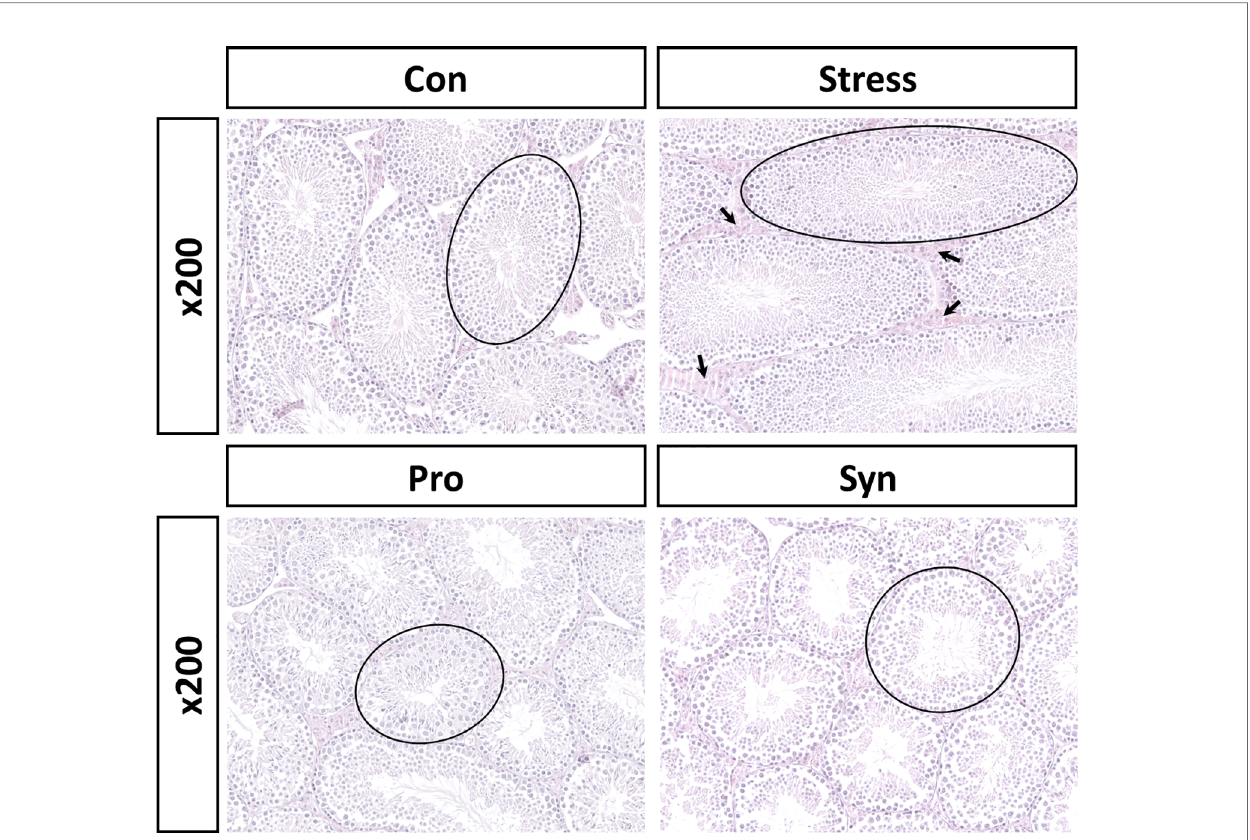
FIGURE 2 | Representative histological sections from mice testes stained with hematoxylin and eosin (calibration bar = 200 m m). Area of seminiferous tubules (black circle), Leydig cell area (black